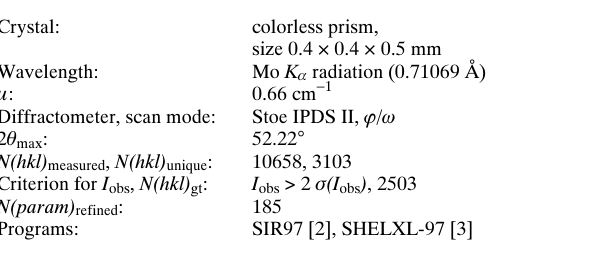
Table 1. Data collection and handling.